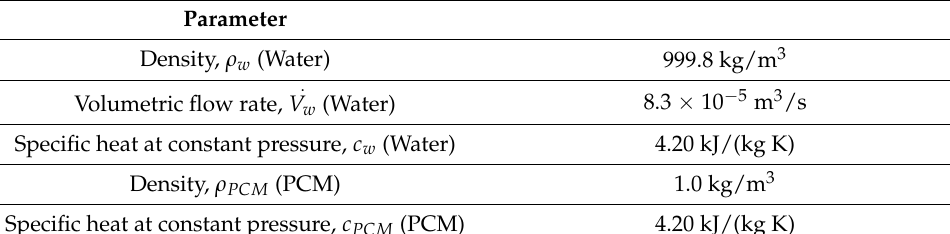
Figure 4. Crystal growth of TBAAc hydrate on the surface of the heat exchanger coil. ( a – d ) illustrate the optical measurement of the hydrate formation at t = 2, t = 2.5, t = 4 and t = 7, respectively. Table 2. The value of each parameter in the